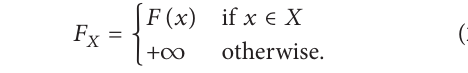
Algorithm 3 (the MADS algorithm). A general and